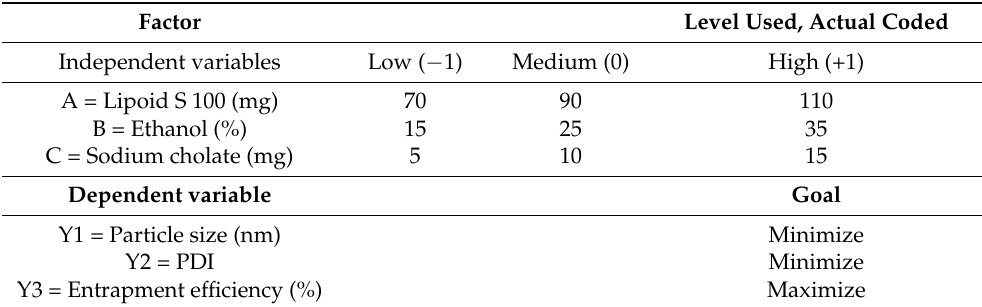
Table 7. List of the independent and dependent factors that were used in the BBD to develop the